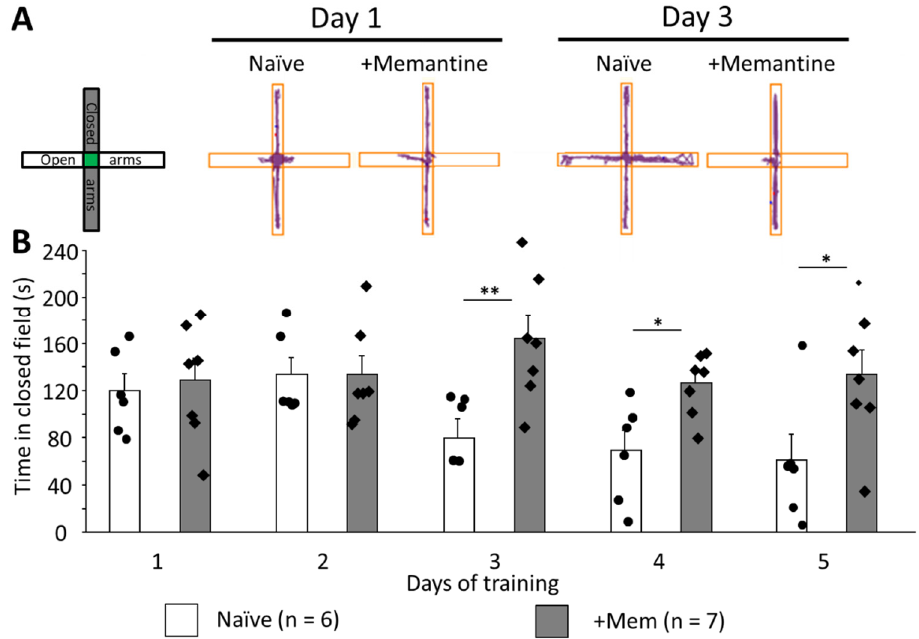
Figure 3. The elevated plus maze test reveals persistent anxiety-like behavior in mice after chronic memantine administration. ( A ) Cumulative movement maps of mice in the arms of the elevated plus maze at day 1 (left panel) and 3 (right panel) of training. ( B ) Time spent in the closed arms. Individual data points are shown as closed circles for control mice and closed diamonds for mice after chronic memantine consumption. By day 3, control mice overcame their anxiety and started exploring open arms while memantine-treated mice remained largely in the closed arms (* p < 0.05; ** p < 0.001; n is number of mice in each group).